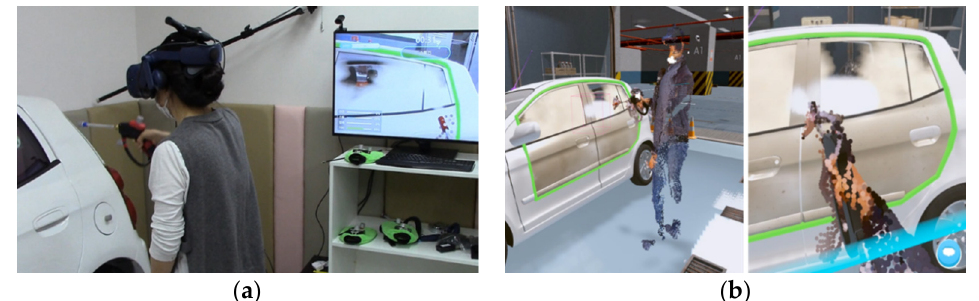
Figure 15. Steam wash system: ( a ) Virtual environment; ( b ) Training content.